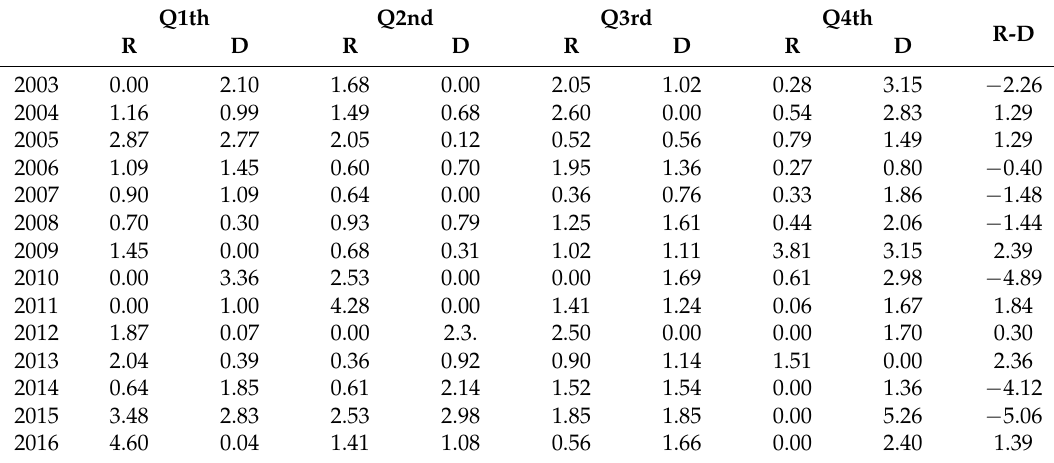
Table 1. Time series of GWSC seasonal division table.